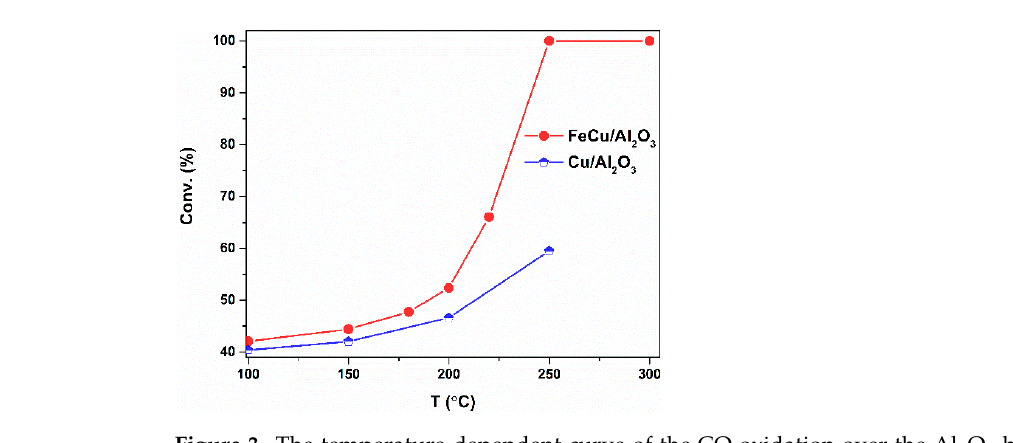
Figure 3. The temperature-dependent curve of the CO oxidation over the Al 2 O 3 -based catalysts. Reaction conditions: W cat = 0.3 g, F tot = 100 mL/min, P CO = 0.02 bar, O 2 /CO = 10/1, P tot = 1 bar.